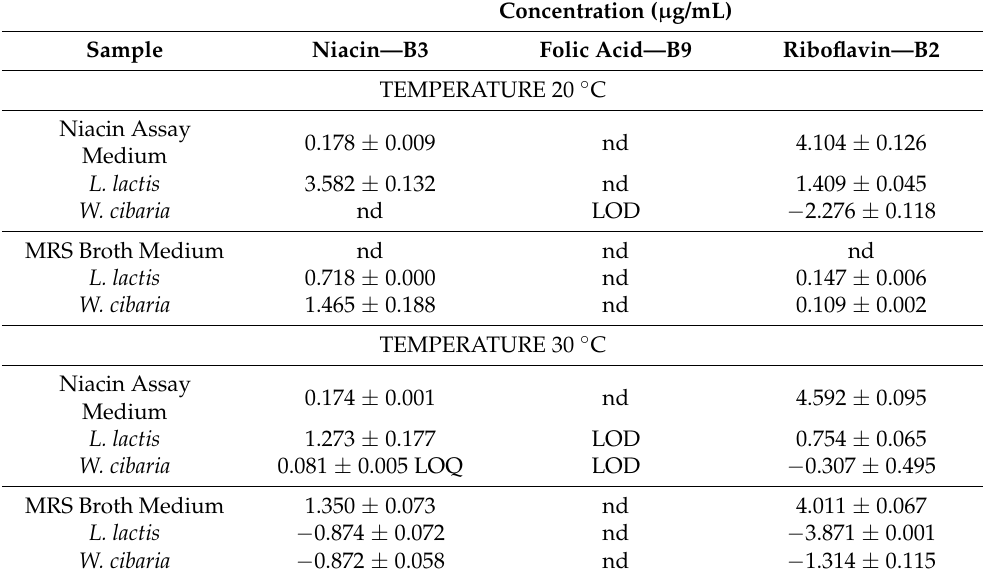
Table 6. Concentration of the analyzed vitamins in the niacin assay medium and the post-culture fluid of LAB strains obtained using HPLC analysis. During the analysis, the concentrations of the analyzed vitamins in the clean medium were taken into account (values for LAB strains shown in the table are after background subtraction). nd—not detected; LOD—limit of detection; LOQ—limit of